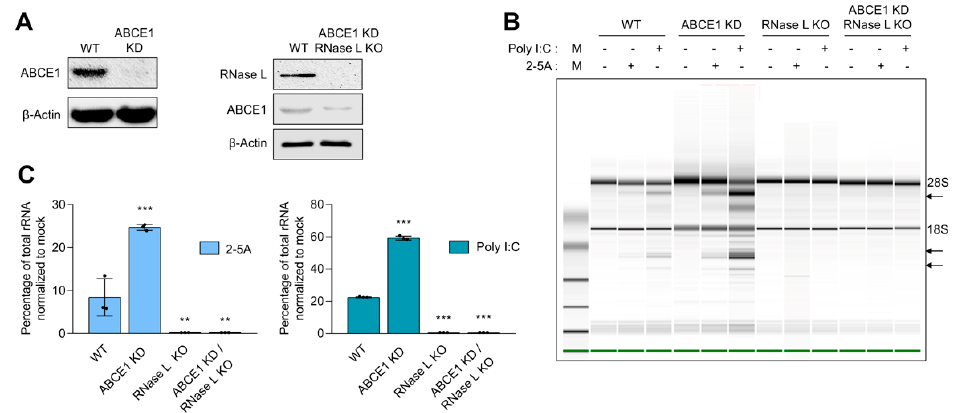
Figure 1. Increased ribonuclease L (RNase L) activity in cells with reduced ATP-binding cassette E1 (ABCE1) protein levels. ( A ) Knockdown of ABCE1 levels using short hairpin RNA (shRNA) in HT1080 WT cells or CRISPR/Cas9 RNase L KO cells was verified in cell lysates by immunoblotting using specific antibodies. ( B ) WT, ABCE1 KD, RNase L KO, and ABCE1 KD/RNase L KO cells were transfected with 2-5A (10 µ M) or 2 µ g/mL of poly I:C for 6 h, and the RNase L-mediated cleavage of rRNA (arrows) was analyzed on RNA chips using Agilent Bioanalyzer 2100. ( C ) The cleavage of rRNA was quantitated and normalized to mock-treated samples. Data are representative of at least three independent experiments and expressed as means ± SD; WT: wild-type; ** p < 0.01; *** p < 0.001.